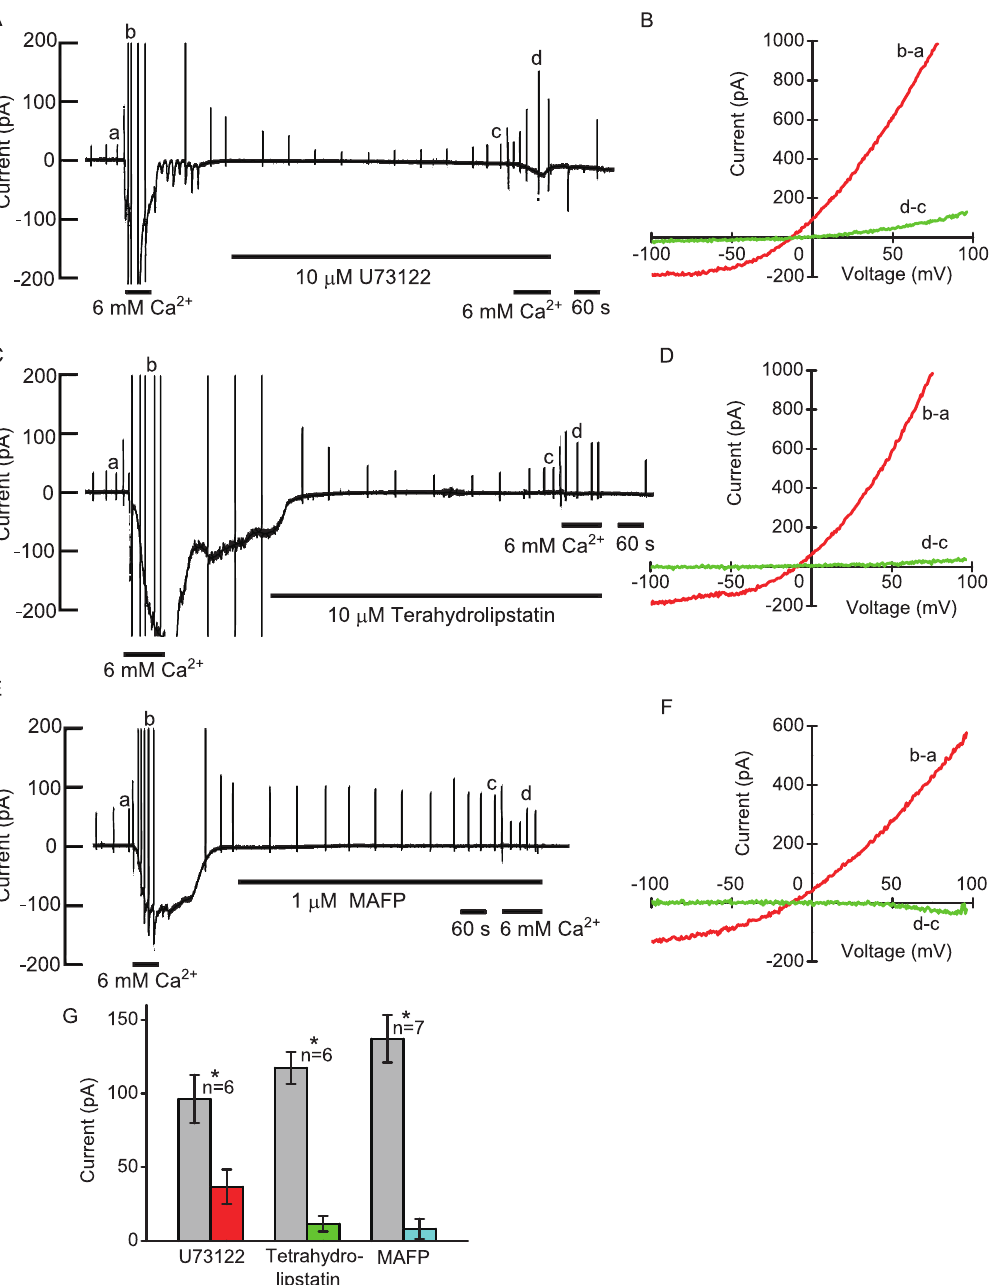
Figure 6. Effects of lipase inhibitors on extracellular Ca 2 + -induced current. (A),(C), (E)The pen recordings of the inhibitory effects of U73122, tetrahydrolipstatin and MAFP on extracellular Ca 2 + -induced current at 2 54 mV. (B),(D),(F) The plots of the whole-cell I/V relationships during control and application of lipase inhibitor. The relationships were obtained from the pen recording on the left. (G) Comparison of the effects of external lipase inhibitors on extracellular Ca 2 + -induced current at 2 54 mV. The pipette solution contained amphotericin B (133 m g/ml).